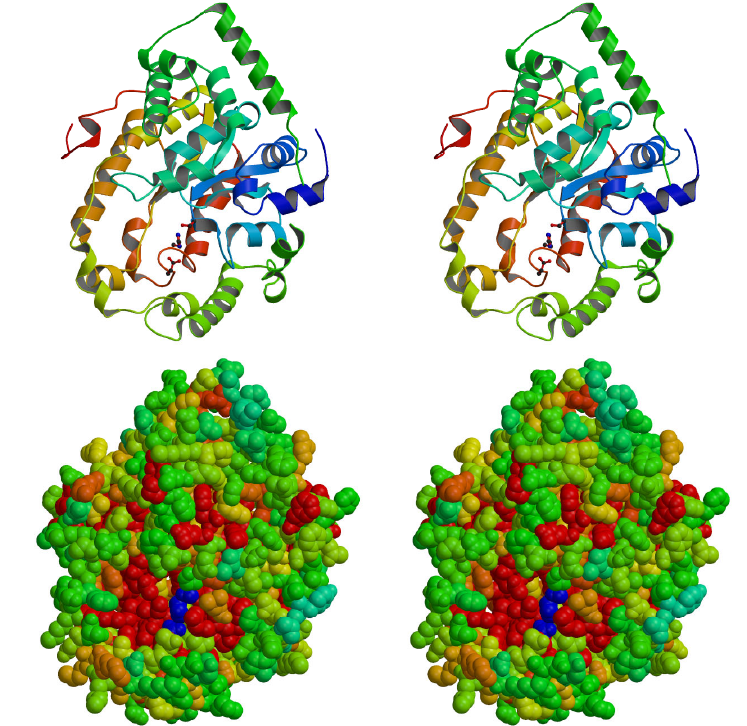
Figure 11. Structure of DltD from Streptococcus pneumoniae in stereo. A , Ribbons diagram of DltD. The side chains in the Ser-His-Asp triad are shown in ball-and-stick model. B , Space-filling model of DltD. The most conserved residues are shown in red, and the least conserved in green. The putative catalytic triad is shown in